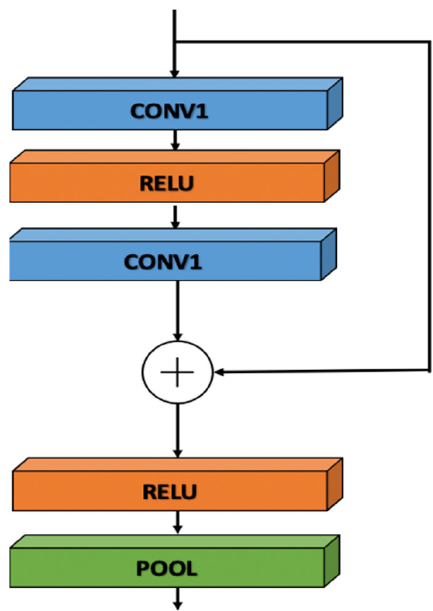
Figure 1. The residual block structure of the multiscale residual network (MsRes).